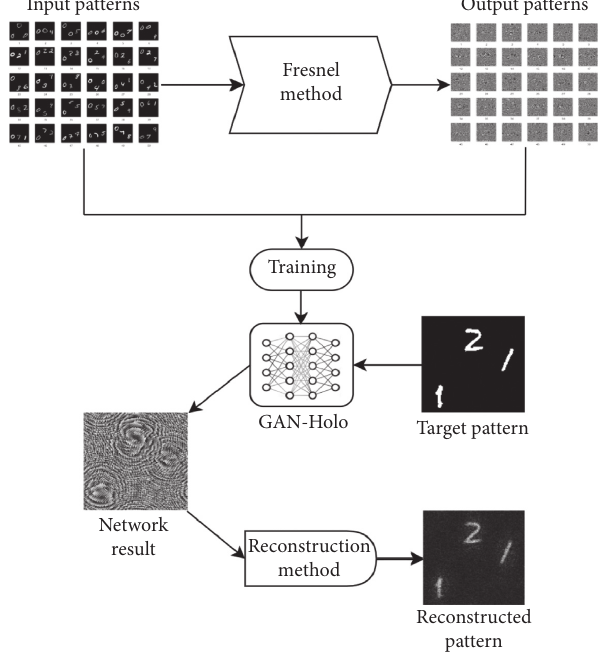
Figure 2: The proposed